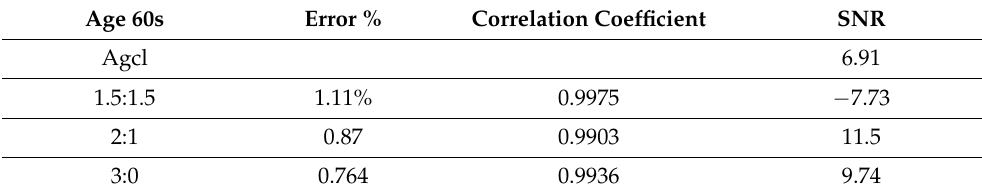
Table 4. Comparison of three different electrode concentrations based on the age group of the